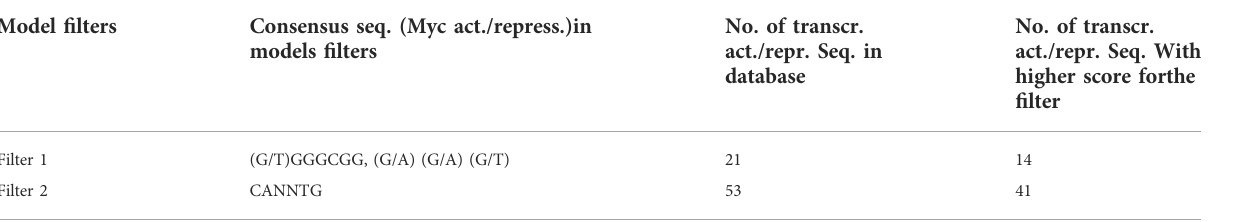
TABLE 3 Comparison of number of detected consensus sequences in fi lters 1 and 2. Model fi lters Consensus seq. (Myc act./repress.)in models fi